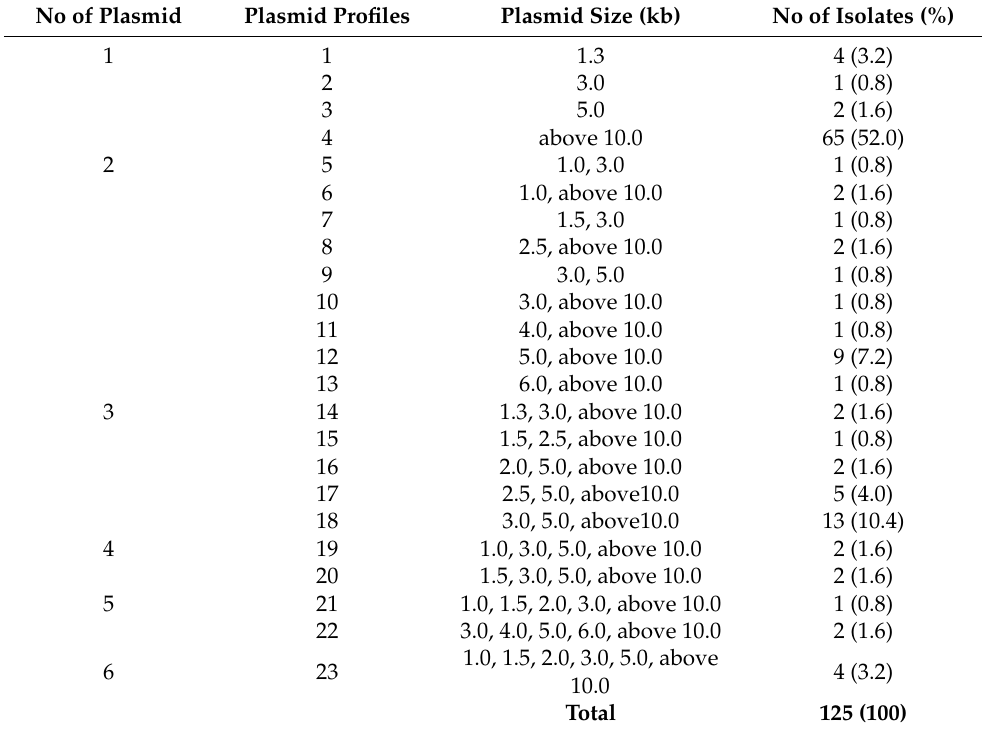
Table 7. Plasmid profiles of the resistance Vibrio isolates (n = 125) in this